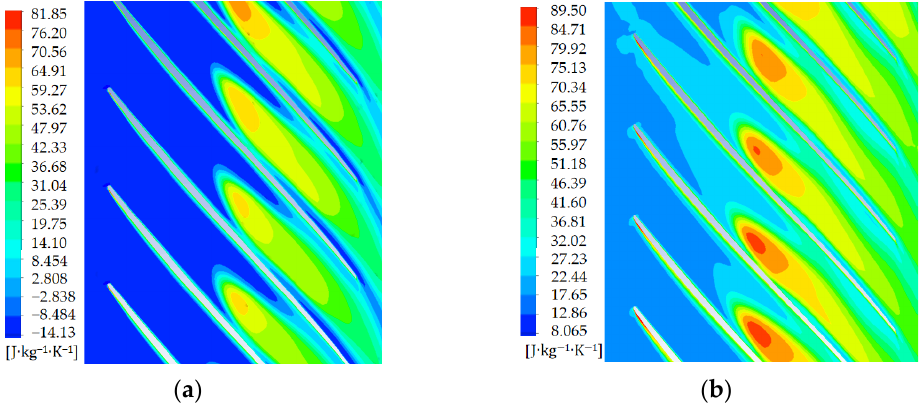
Figure 18. Static entropy contours of 90% heights of impellers. ( a ) First stage. ( b ) Second stage.